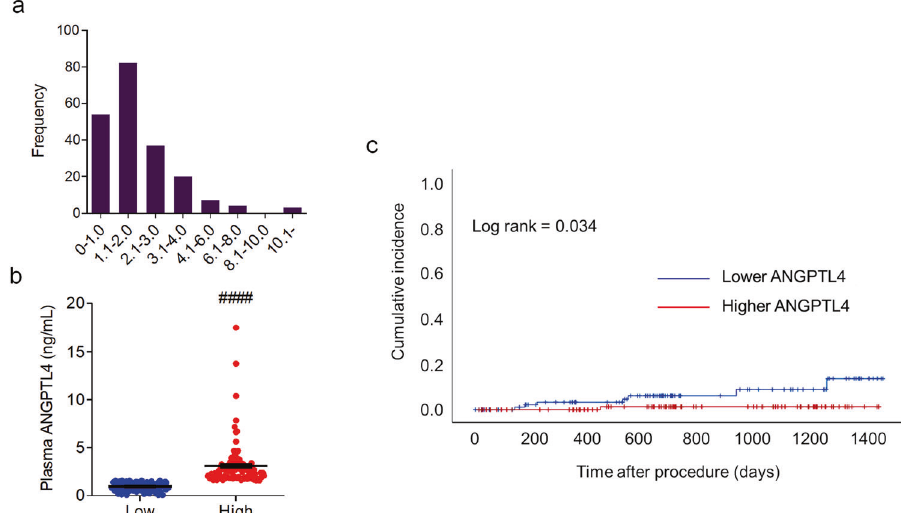
Fig. 8 Circulating levels of ANGPTL4 in patients with cardiovascular disease. a Distribution of plasma levels of ANGPTL4 measured in all patients ( n = 207). b Plasma levels of ANGPTL4 in the low ANGPTL4 ( n = 103) and high ANGPTL4 ( n = 104) groups. c Kaplan ‒ Meier curve illustrating the vascular event incidence of patients during the follow-up period after surgery based on plasma ANGPTL4 levels above (red) and below (blue) the median value. Data were presented as the mean ± SEM. #### p < 0.0001 (by Student ’ s t -test).